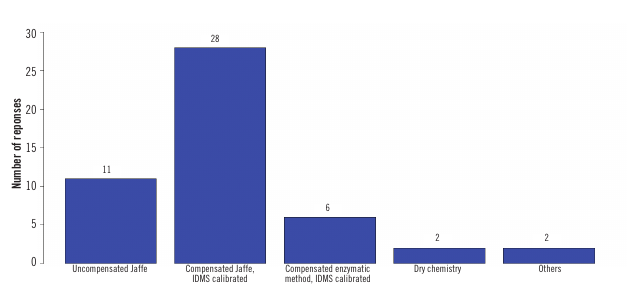
figurE 1 − Laboratory methods for serum creatinine measurement IDMS: isotope dilution mass